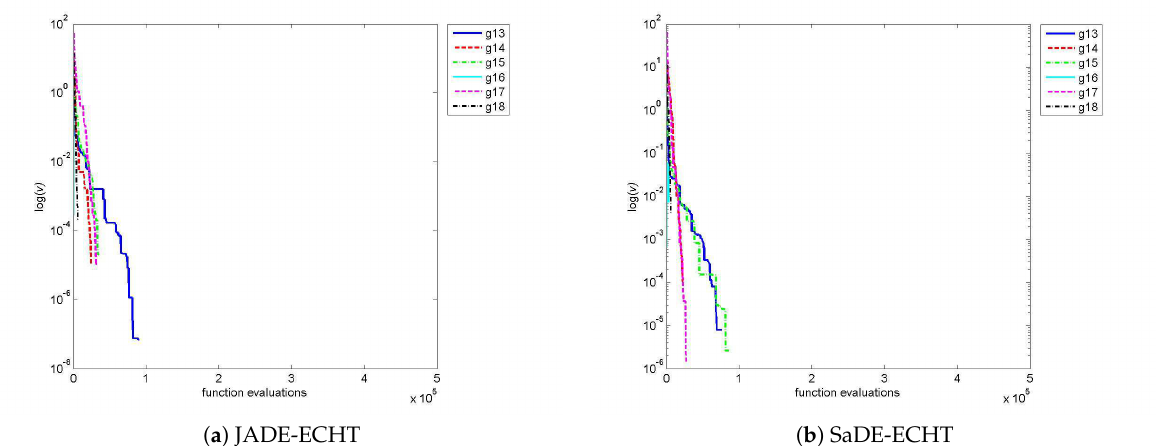
Figure 8. Constraint violation comparison of JADE-ECHT and SaDE-ECHT for